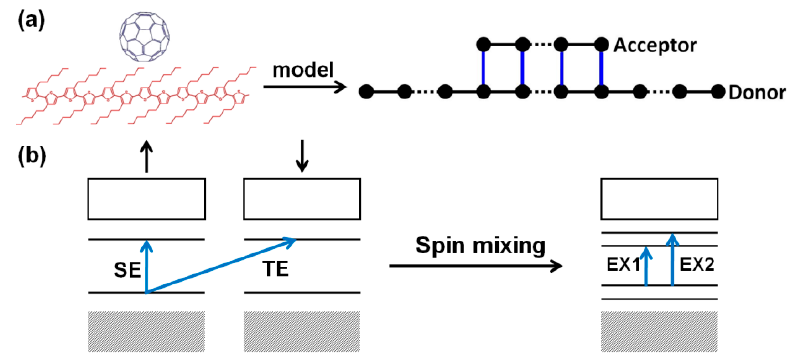
Figure 22. ( a ) Schematic diagram of the nw-P3HT/C 60 charge transfer complex device and corresponding theoretical modeling and ( b ) transitions of photoexcited electrons between HOMOand LUMO before and after spin mixing.